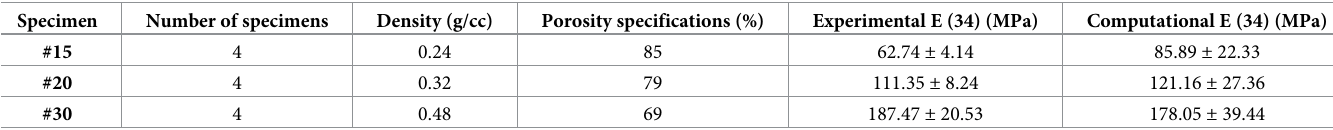
Table 1. Open-cell specimens, densities, porosities, mean experimental Young’s modulus [34] and the mean computational Young’s modulus